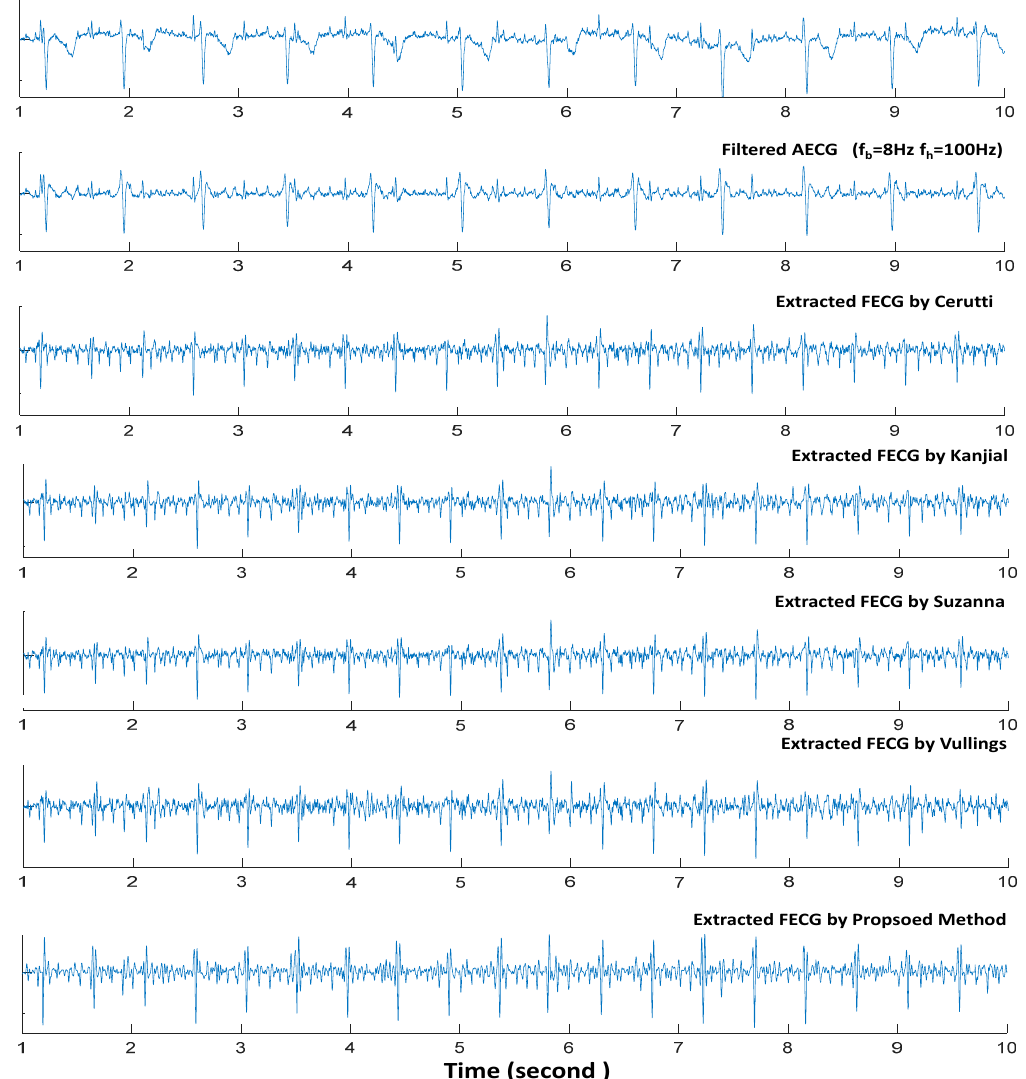
Figure 6. A segment performance using signal r01 (DB1) of our proposed method and other four typical single-channel methods with same preprocessed (low cutoff frequency f b = 8 Hz and high cutoff frequency f h = 100 Hz).